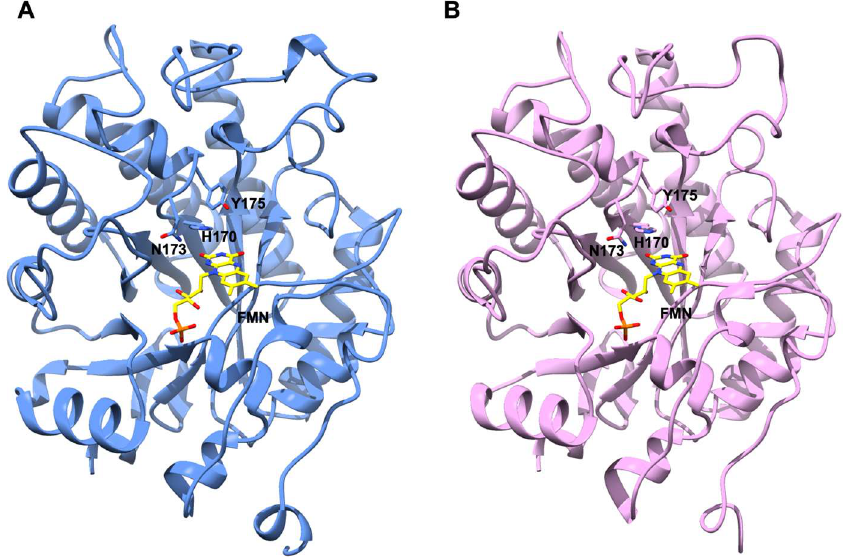
Figure 5. Model structures of An OYE2 (cornflower blue) ( A ) and Bf OYE1 (pink) ( B ). FMN cofactor docked in the active site is shown with C atoms in yellow. The conserved catalytic residues His170, Asn173, and Tyr175 are shown as sticks in both models.